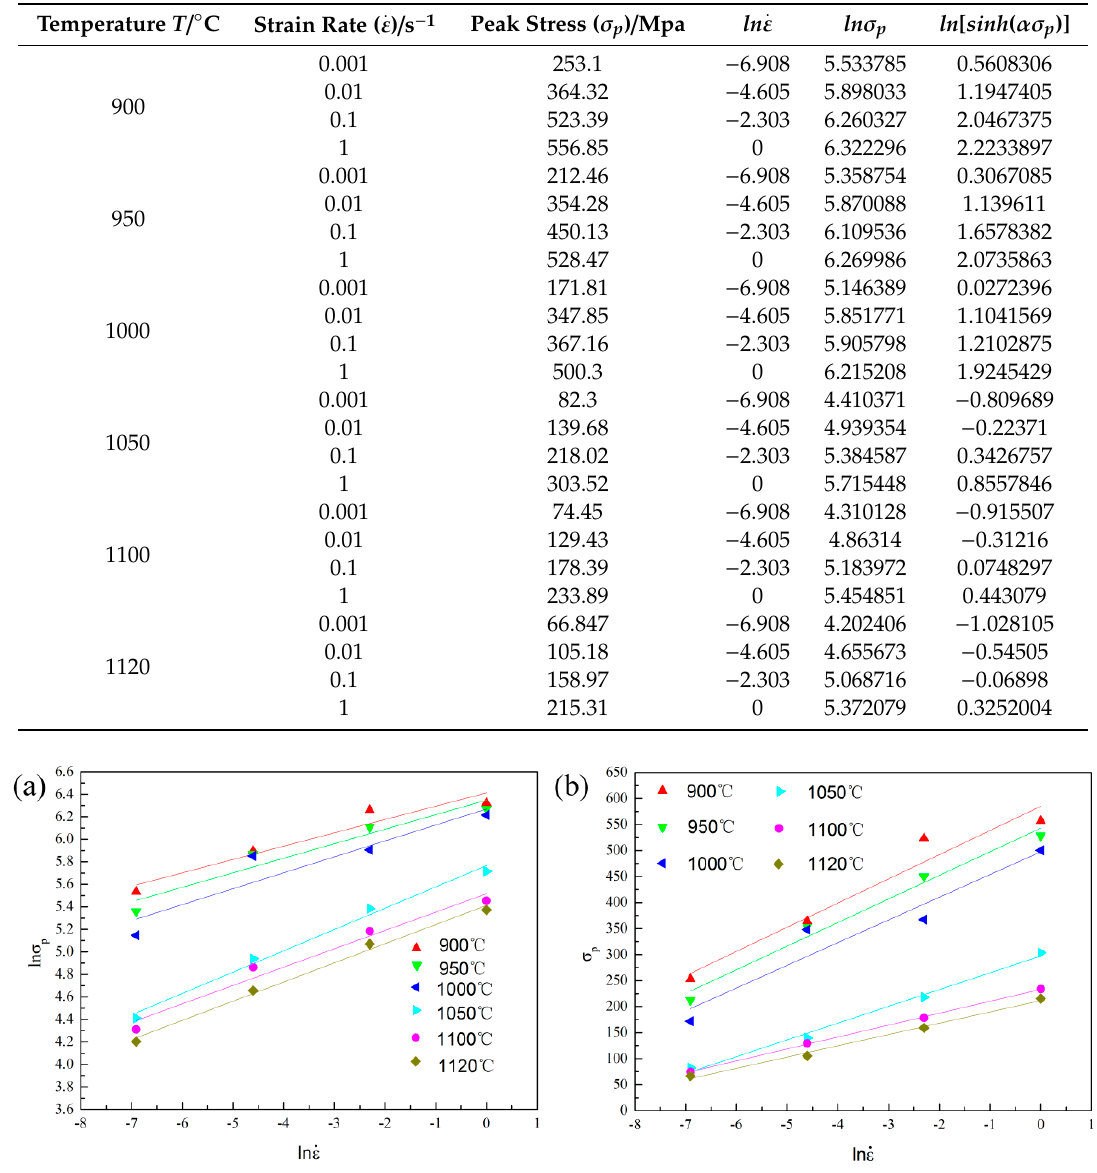
. ε curves at di ff erent temperatures. ( a ) ln σ p and ln